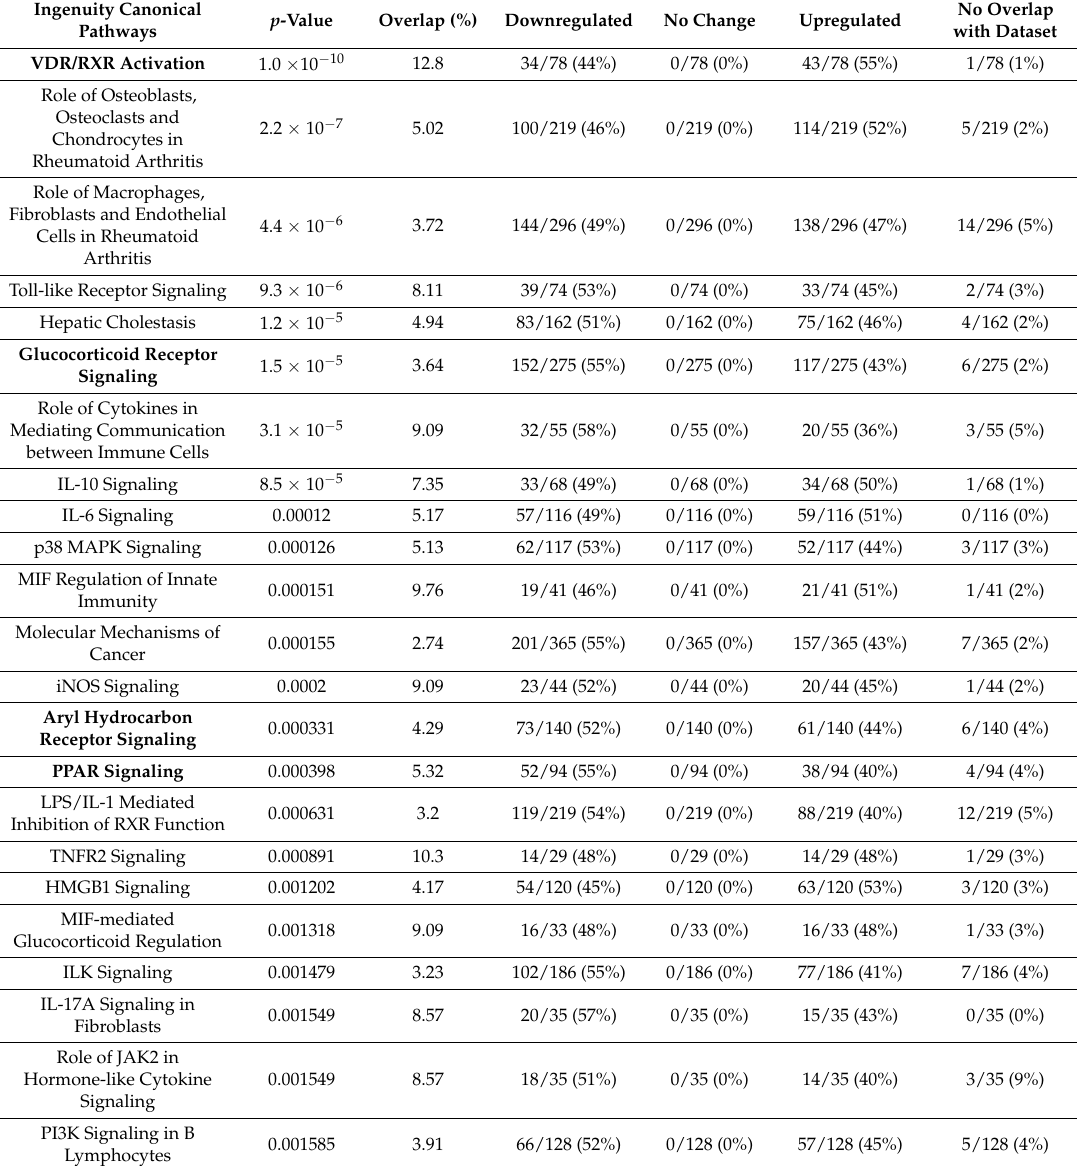
Table 2. Canonical pathways activated by 1,25(OH) 2 D3 in human epidermal keratinocytes after 6 h of treatment. Nuclear receptors are marked in